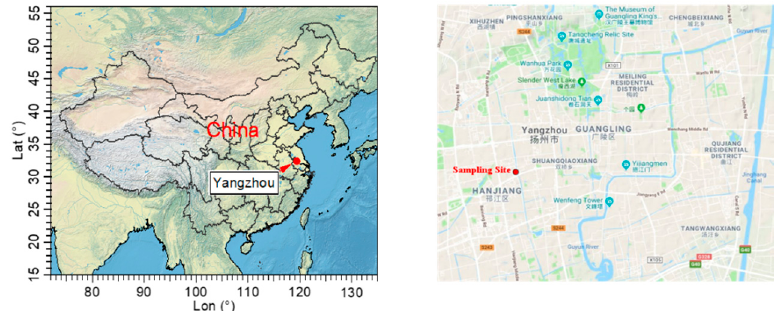
Figure 1. Sampling site and its surrounding areas.